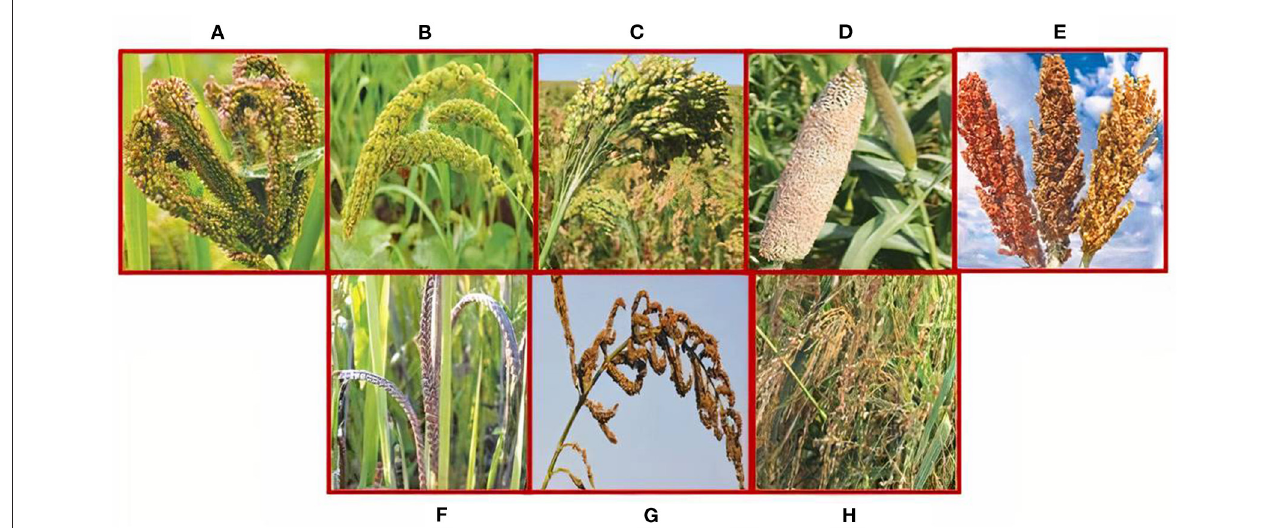
FIGURE 1 | Major millets: (A) finger millet ( Eleusine coracana ), (B) foxtail millet ( Setaria italica ), (C) proso millet ( Panicum miliaceum ), (D) pearl millet ( Pennisetum glaucum ), and (E) sorghum ( Sorghum bicolor ). Minor millets: (F) kodomillet ( Paspalum scrobiculatum ), (G) barnyard millet ( Echinochola spp.), and (H) little millet ( Panicum sumatrense